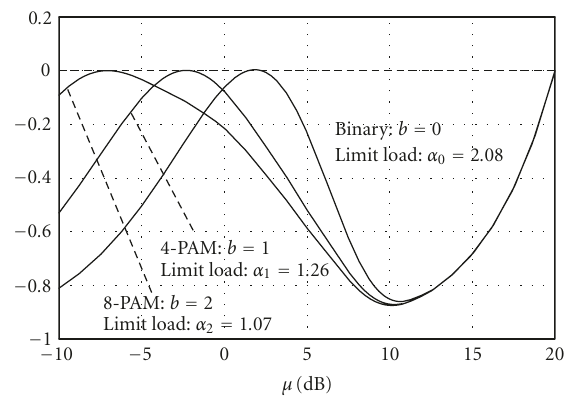
Figure 3: Convergence function (25) for binary, 4-PAM, and 8- PAM modulations and large signal-to-noise ratios.